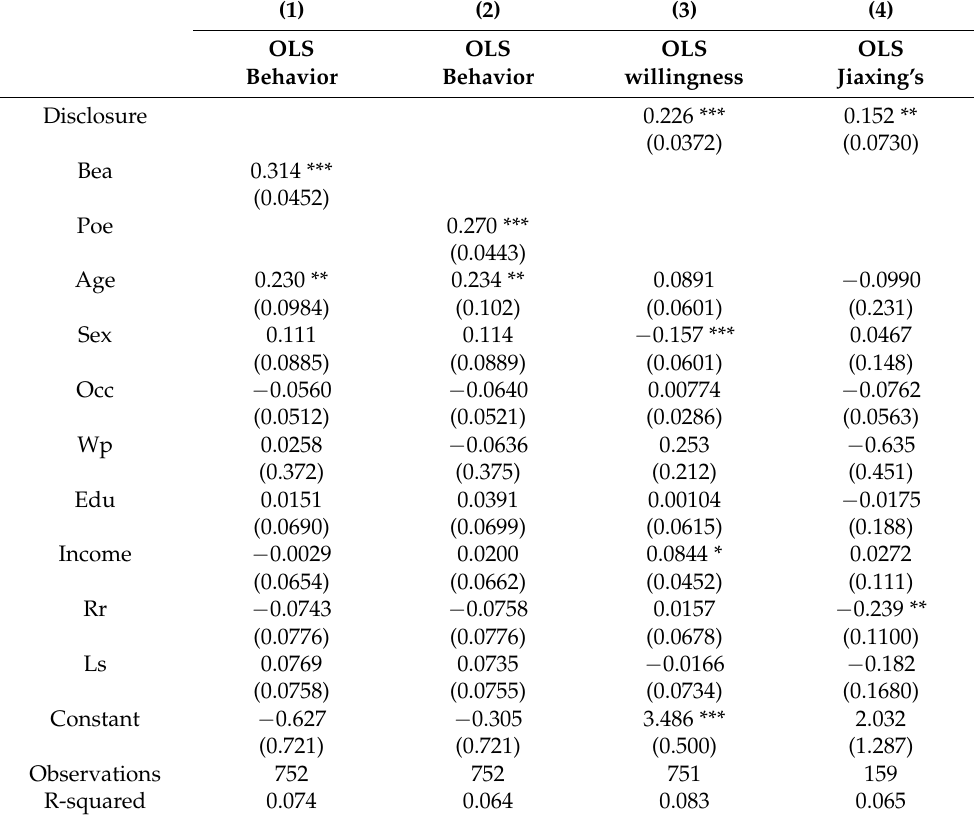
Table 4. Robustness test for replacement of independent variables, dependent variables, and sample